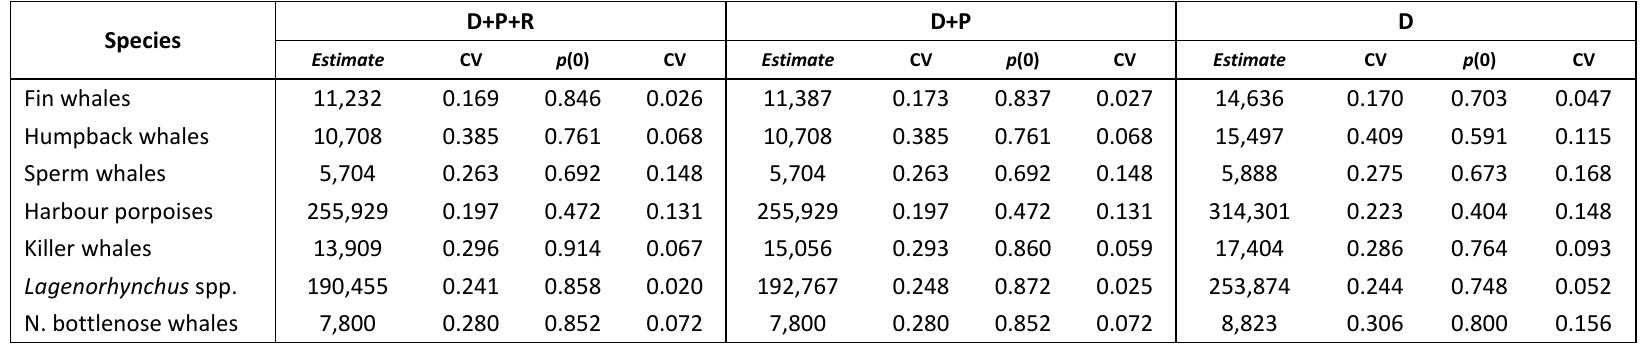
Table 4. Estimated p (0) and corresponding abundance estimates using 3 combinations of duplicates: definite (D), definite + probable (D+P), and definite + probable + remote